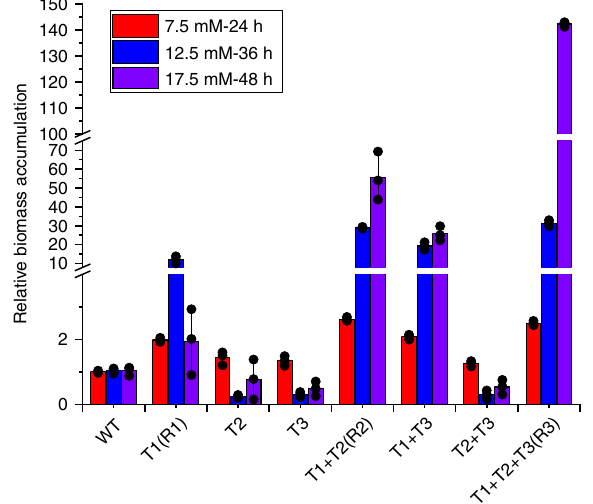
Fig. 4 Synergistic interactions among iMAGIC identi fi ed targets (T). Single (T1, T2, and T3), double (T1 + T2, T1 + T3, and T2 + T3), and triple (T1 + T2 + T3) mutants were constructed to investigate the synergistic interactions among SIZ1i , NAT1a , and/or PDR1i for enhanced tolerance against furfural with a fi nal concentration of 7.5 mM (red), 12.5 mM (blue), and 17.5 mM (purple). Error bars represent the mean ± s.d. of biological triplicates. The source data are provided as a Source Data fi